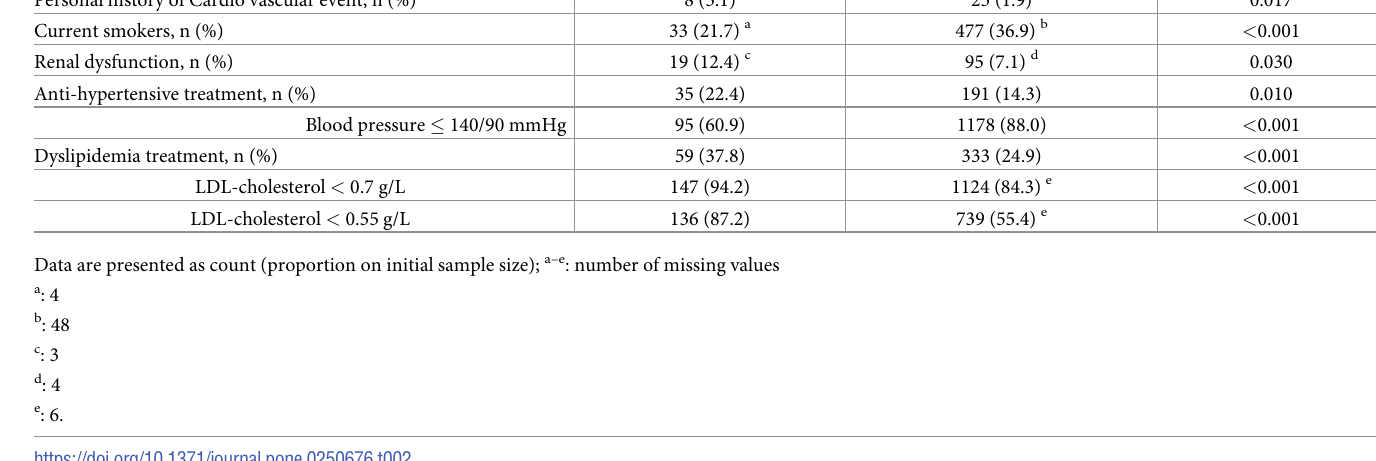
DM patients Non DM